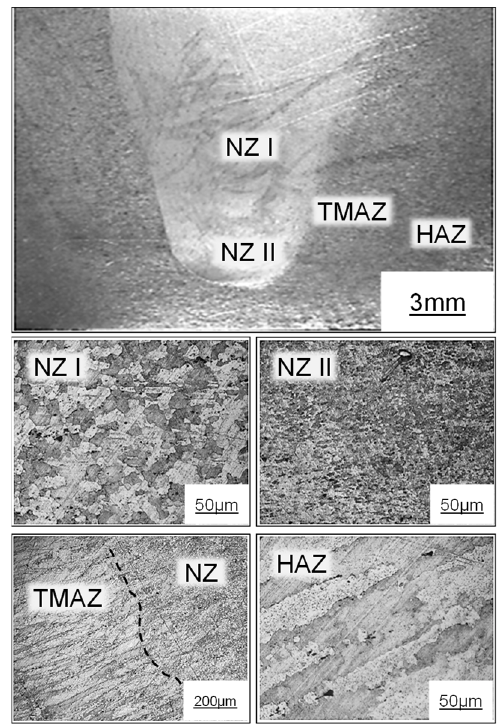
Figure 1. Microstructural changes in the friction stir welding (FSW) weld union in 2050 aluminum alloy .